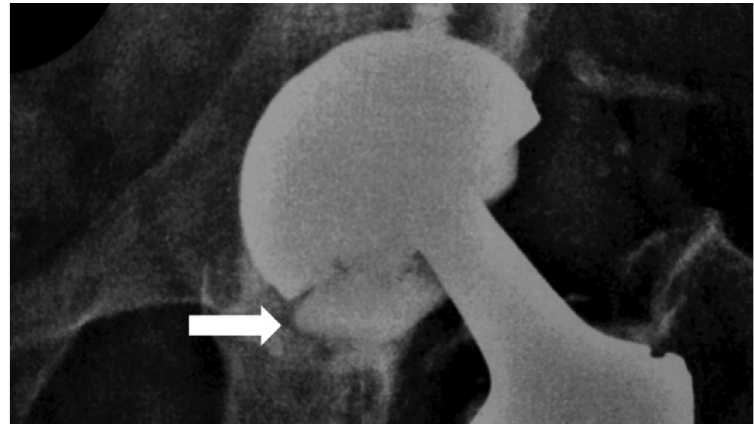
Preoperative radiograph (fractured ceramic liner indicated by arrow). Fig. 1: